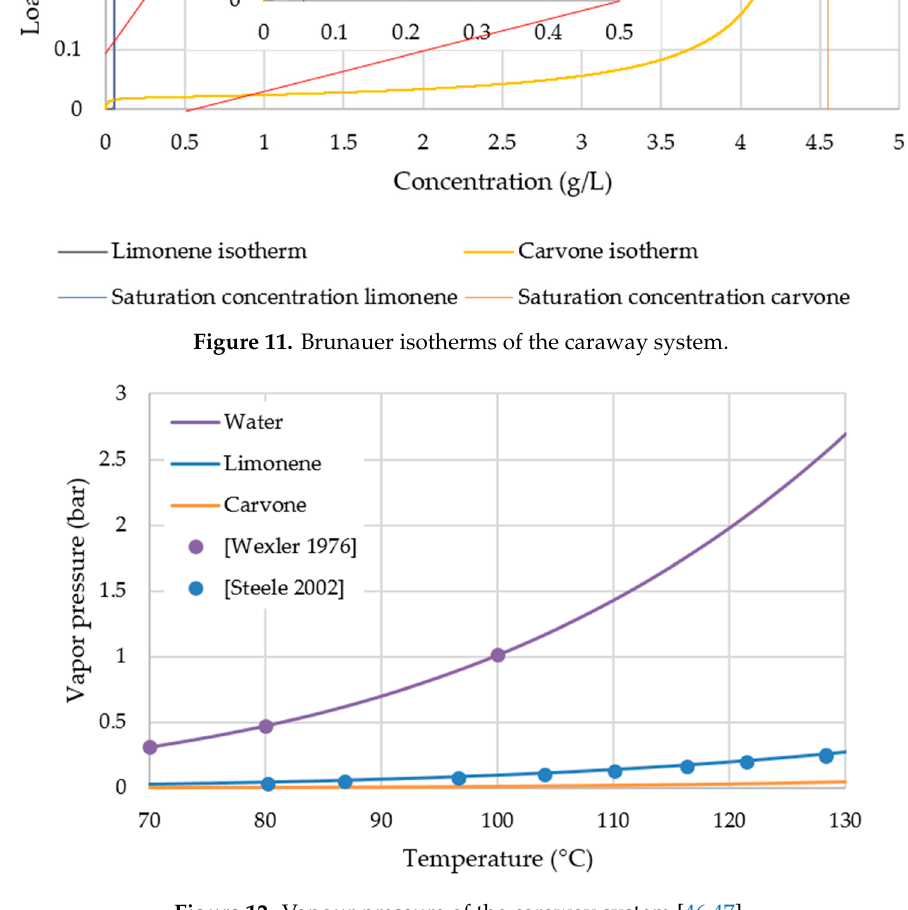
Figure 12. Vapour pressure of the caraway system [46,47].